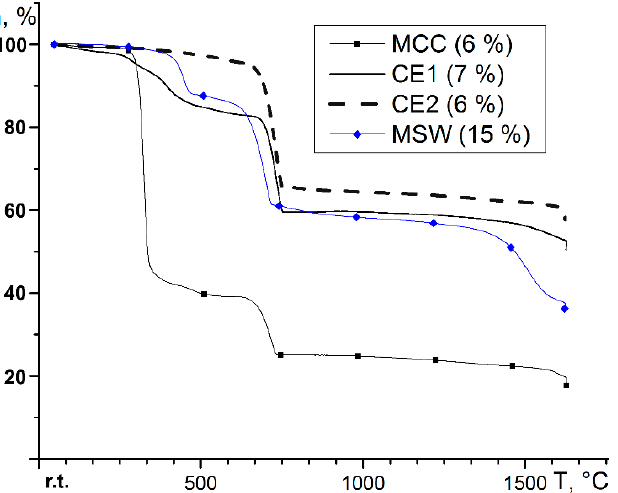
Figure 5. Weight loss in calcium carbide synthesis from waste materials: microcrystalline cellulose, cation exchangers, and municipal solid wastes.